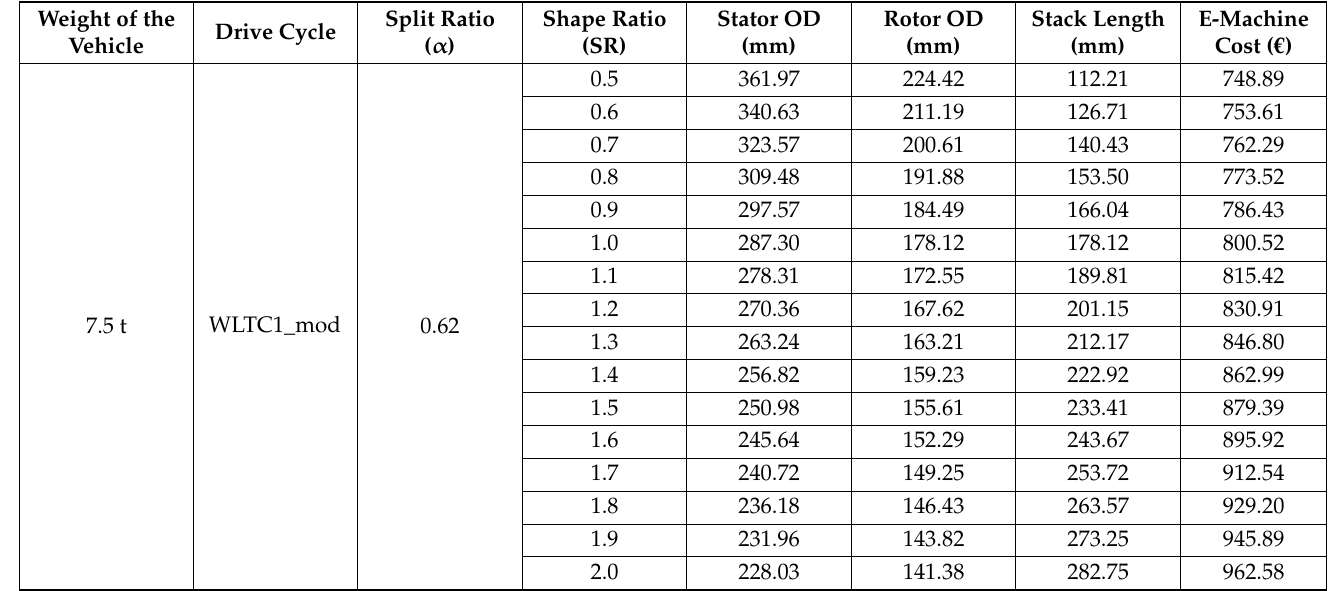
Table 8. Overview of the behavior of e-machine cost based on different combinations of